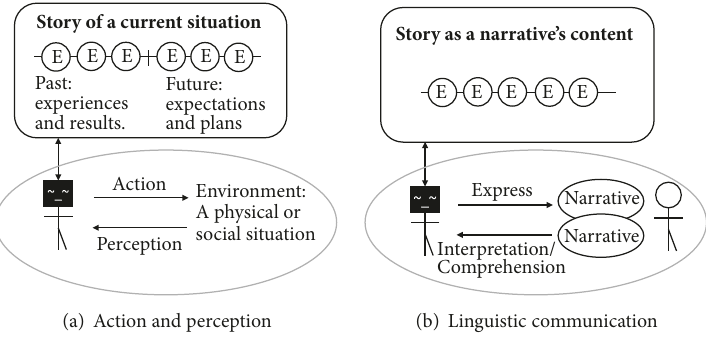
Figure 3: Action/perception and linguistic communication based on a